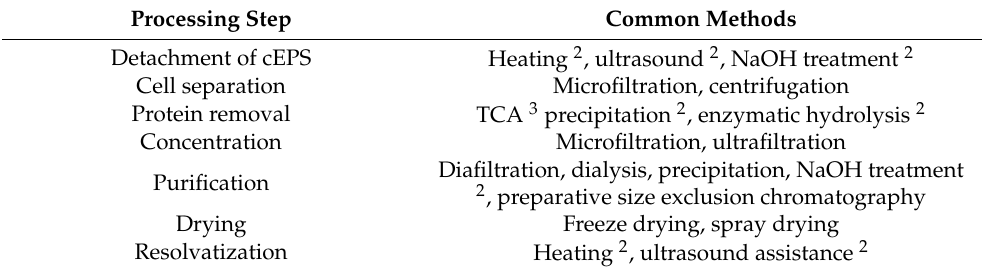
Table 1. Processing steps commonly used for exopolysaccharides (EPS) isolation and purification 1